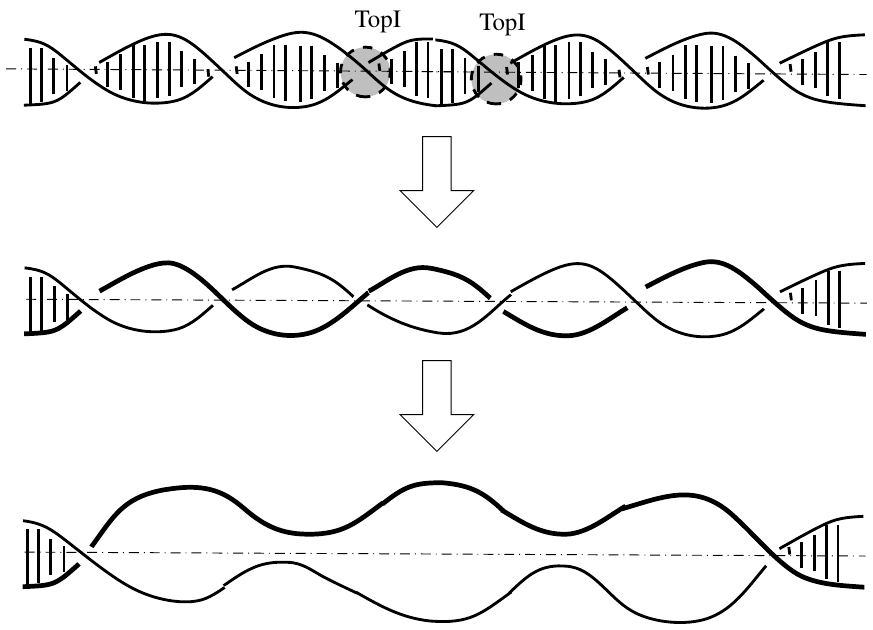
Fig. 13. The topological model of the rewinding at the replication origin. TopIA is activated at the shaded circles in the top diagram. This releases 2.5 full twists. This model keeps the writhe of the single strands. It does not require too many extra